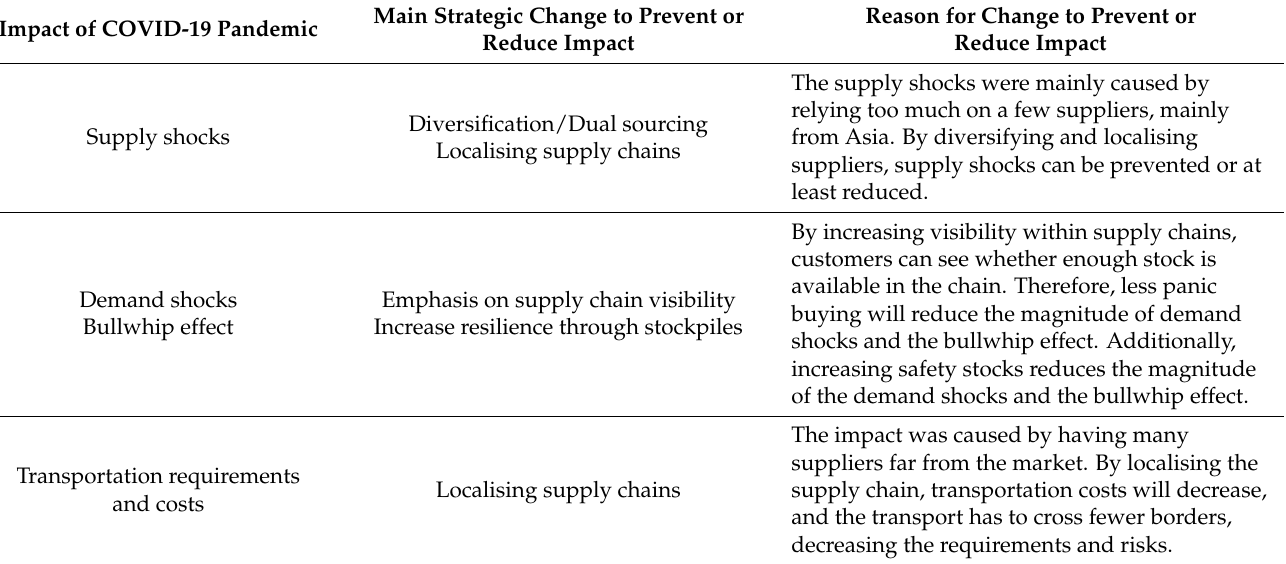
Table 1. Connections and explanation of impacts of COVID-19 and corresponding strategic